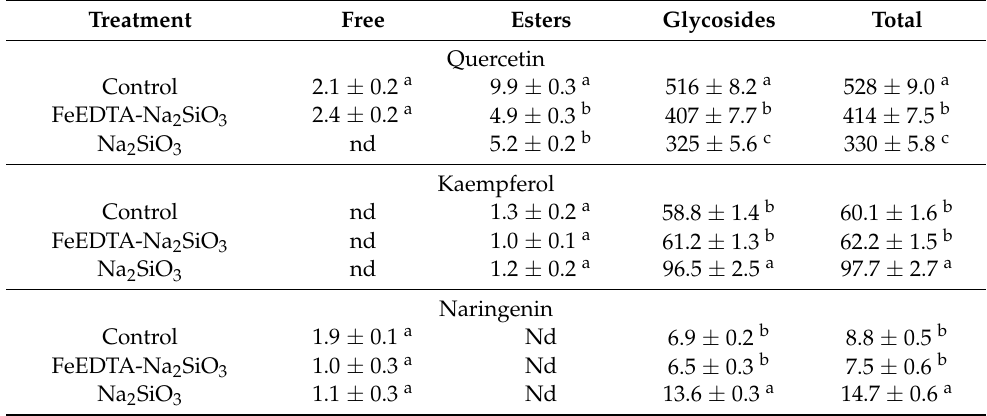
Table 1. The content ( µ g/g DW) of flavonoids (free, released from ester and O -glycoside forms, and in total) in broccoli sprouts treated with elicitors during